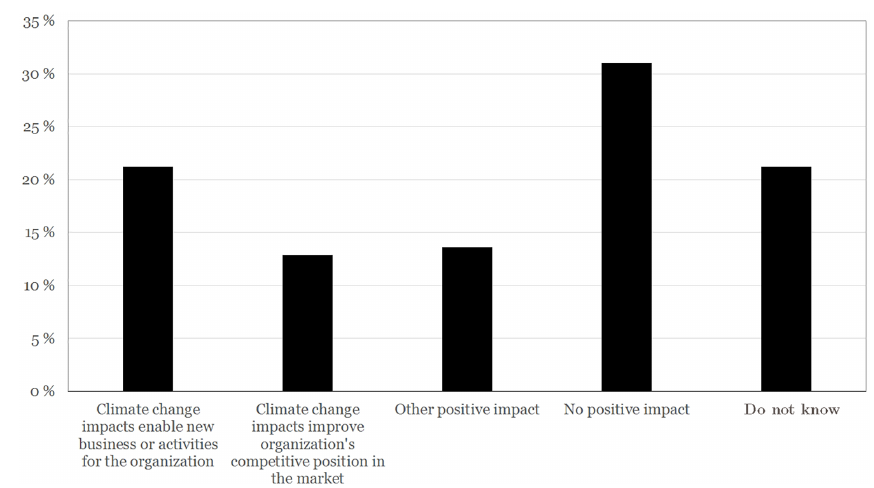
Figure 1. The respondents’ view on the question “Does climate change result in beneficial impacts to your organization?” (Appendix A, Question #12).